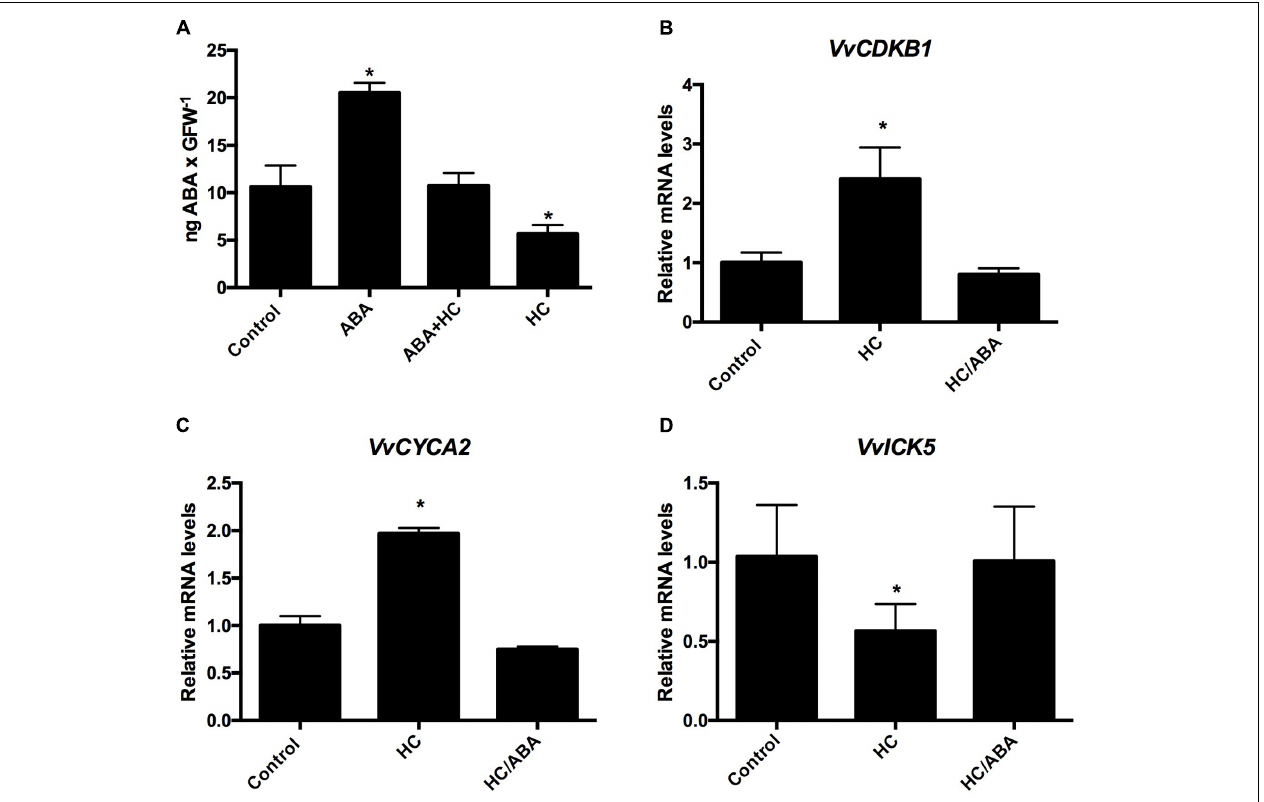
FIGURE 7 | Incorporation of ABA into grapevine buds (A). Co-applications of HC and ABA on the expression of CCG in grapevine buds (B–D) . The content of ABA was determined in latent grapevine buds collected on March 23 after the application of the following solutions 100 µ M ABA, 100 µ M ABA + 2.5% HC, 2.5% HC and water as control. Values are the average of three biological replicates ± SD; (asterisk) represents significance difference with respect to the control (Dunnett’s multiple comparison test p < 0.05). Single-bud cuttings of Thompson seedless grapevine collected on March 23 were sprayed with the following solutions 2.5% HC, 2.5% HC + 100 µ M ABA and water as control and 48 h after treatment gene expression analysis was performed by RT-qPCR and normalized against VvUBIQUITIN . Values are the average of three biological replicates with three technical repetitions ± SD; (asterisk) represents significance difference with respect to the control (Dunnet’s multiple comparison test p <